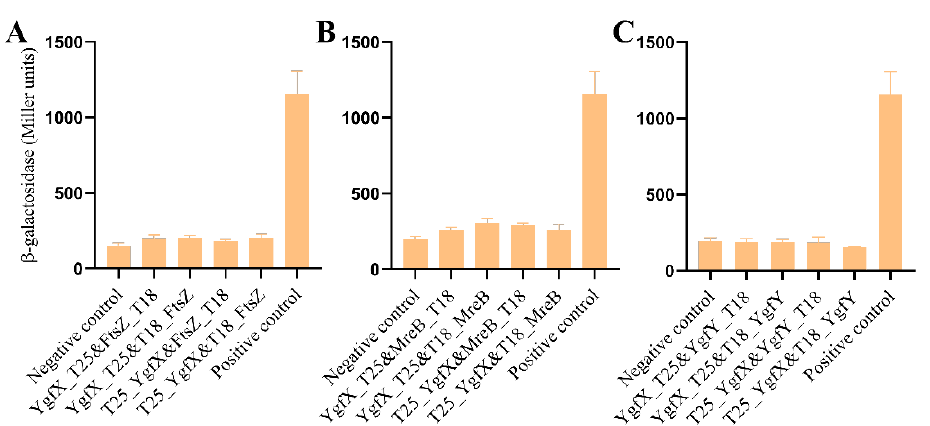
Figure 4. YgfX did not interact with ( A ) MreB, ( B ) FtsZ, and ( C ) YgfY. E. coli BTH101 expressing YgfX and the other protein simultaneously was examined for β -galactosidase activity in cells. The data are the mean ± SD ( n = 3).